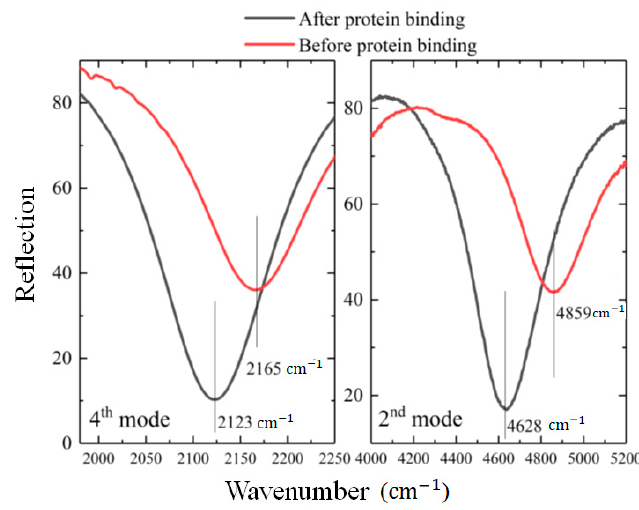
Figure 6. A strong red-shift after a couple of nm-thick protein binding on the PA surface is observed on fourth mode ( left ), and second mode ( right ). All the modes present a red-shift, where sensitivity is on the order of 100 nm/RIU for a 3 nm-thick protein monolayer. The results show the eligibility of the presented PA as a point-of-care device for the detection of S100A9 molecule in clinical brain metastasis studies. The corresponding device parameters: L 1 = L 5 = 550 nm, L 2 = L 4 = 700 nm, L 3 = 600 nm, L 6 = 1200 nm, S = 200 nm, D = 100 nm and w = 100 nm, and array periodicity is 1.7 µm.